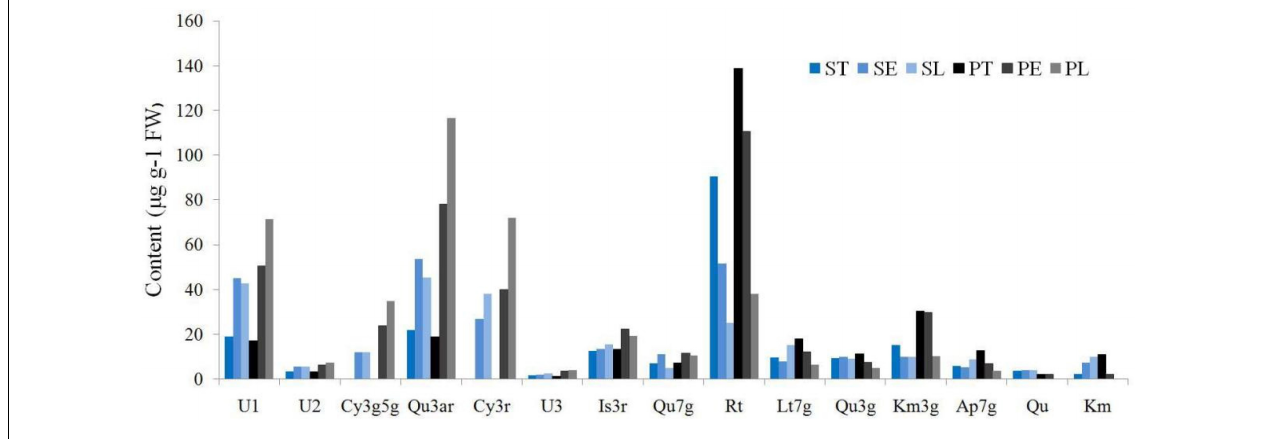
FIGURE 4 | The flavonoids distribution among different floral